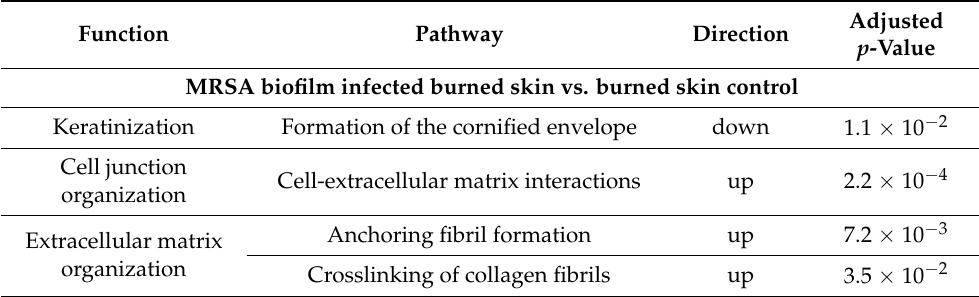
Table 1. Selected pathways dysregulated by MRSA biofilm infection with or without DJK-5 treatment in thermally damaged N/TERT skin. Pathway enrichment analysis was performed on DE genes using ReactomePA [27] with an adjusted p -value < 0.05 used as the cut-off for overrepresented differentially expressed